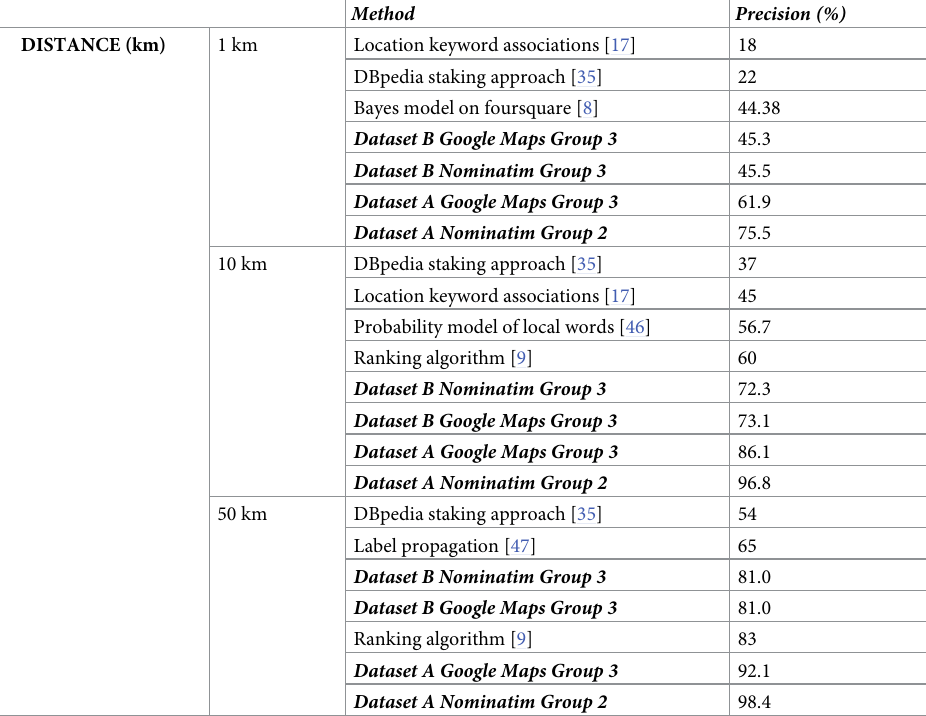
Table 8. Summary comparison of precision values between existing approaches which inferred a tweet’s point of origin and our developed approaches. The table is arranged by ascending order of precision value within each error